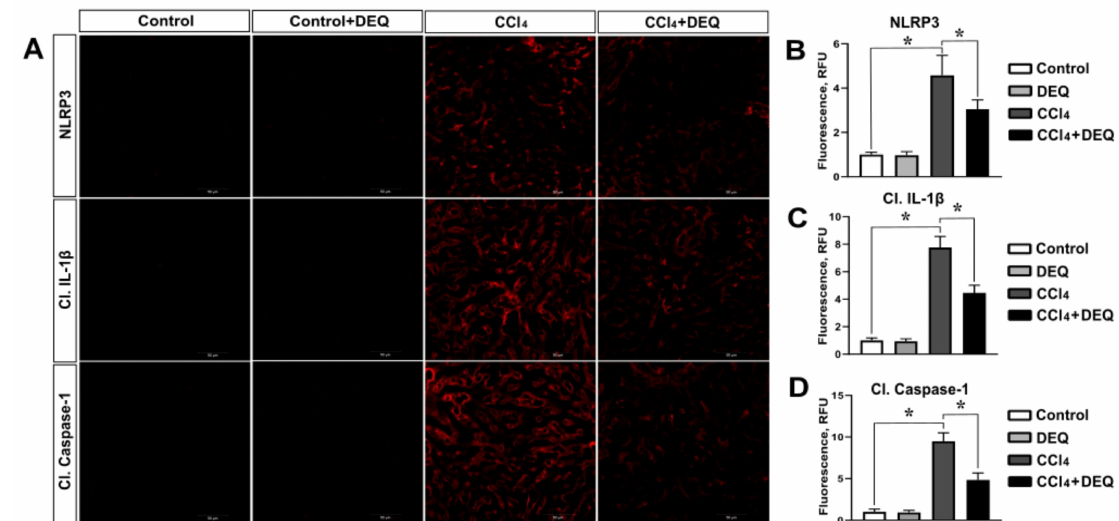
Figure 4. Effect of DEQ administration on NLRP3 inflammasome activation and subsequent pyroptosis with liver damage induced by CCl 4 . Representative microphotographs ( A ) and quantification of NLRP3 ( B ), cleaved IL-1 β ( C ), and cleaved caspase-1 ( D ) across the groups. The NLRP3, IL-1 β , and caspase-1 expression levels were significantly increased in in CCl 4 group compared to the control group. Treatment of rats with DEQ 3 h after CCl 4 administration every 24 h for 4 days significantly reduced NLRP3 inflammasome activation determined by the reduced protein expression of NLRP3, cleaved caspase-1, and IL-1 β . The level of NLRP3, IL-1 β , and caspase-1 proteins in DEQ group remained relatively unchanged compared with the control group. * p < 0.05. All values are expressed as fold change ± SD. Scale bar: 50 µ